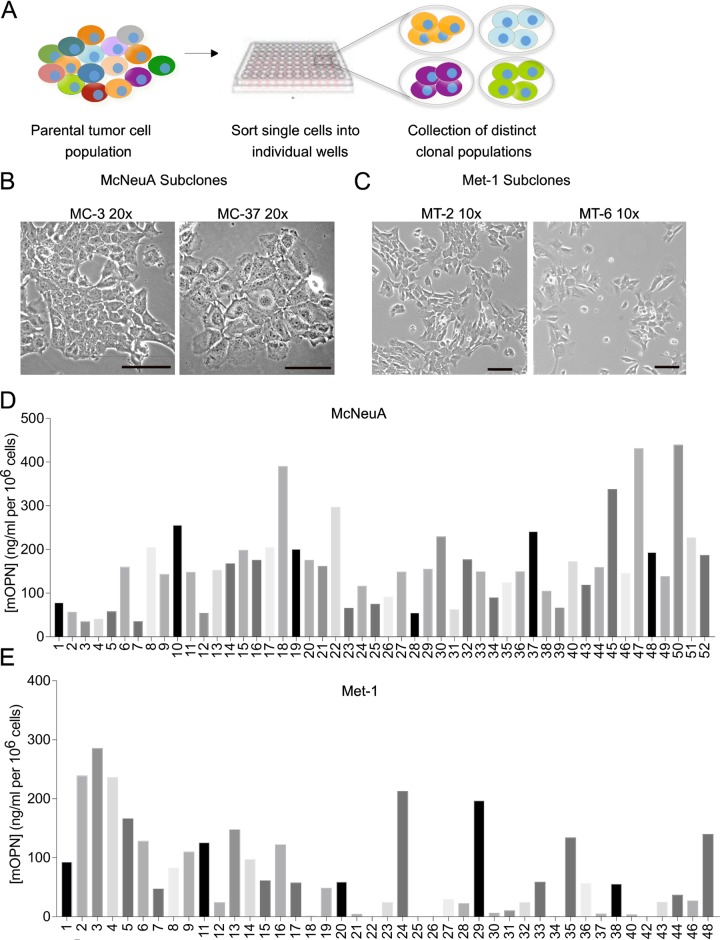
Phenotypic heterogeneity of McNeuA and Met-1 subclonal populations.(A) Schematic of subclone derivation from breast cancer cell lines. (B,C) Phase contrast images of representative McNeuA (B) and Met-1 (C) subclones to demonstrate morphologic variability. Scale bars = 100 μm. (D,E) Concentration of murine osteopontin (mOPN; ng/ml per 106 cells) in 24-hr conditioned media from McNeuA (MC) sublcones (D) and Met-1 (MT) subclones (E).